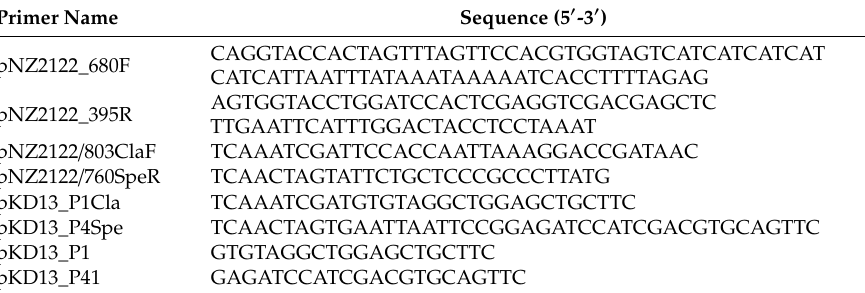
Table 1. The PCR primers list.